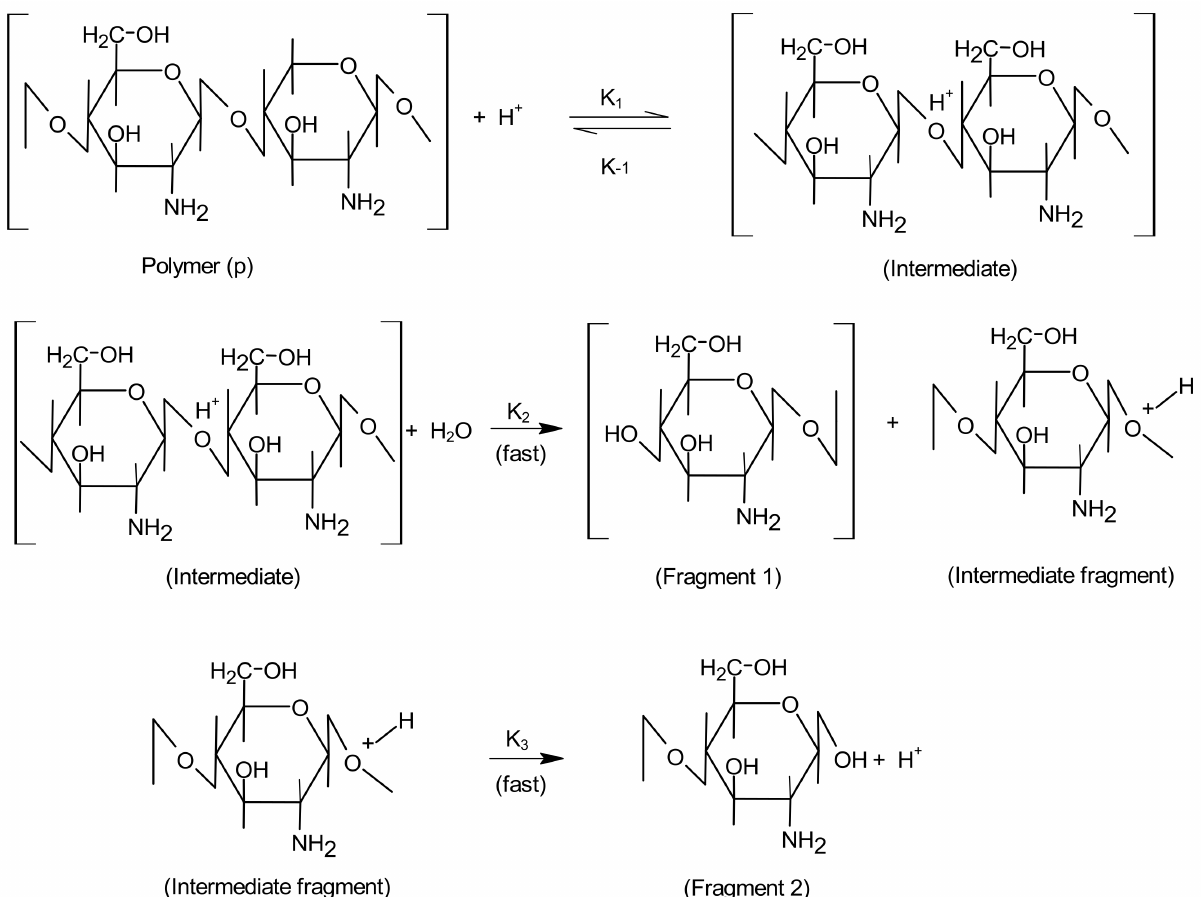
Figure 3. Mechanism proposed for acid hydrolysis of chitosan. Reprinted from Kasaai et al. [24] with permission from Creative Commons